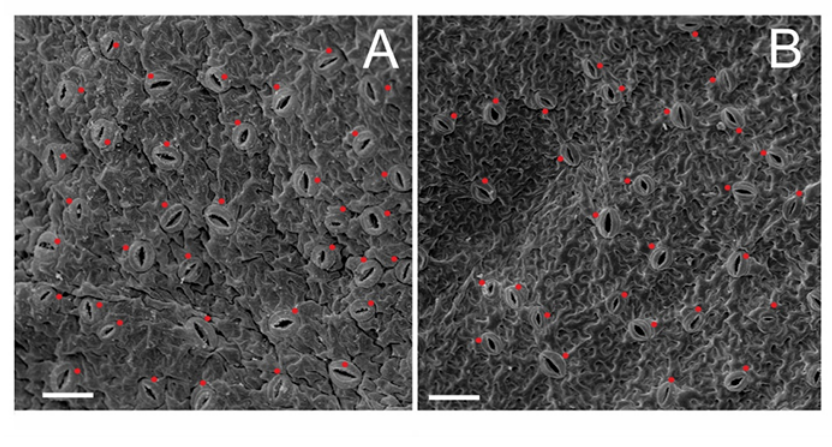
Figure 1 Electronograms of epidermal surfaces with stomata (red dots) from abaxial surfaces of Actinidia chinensis var. deliciosa leaves; ( A ) endosperm-derived nonaploid 9Cx, and ( B ) control hexaploid 6Cx. Scale bars = 100